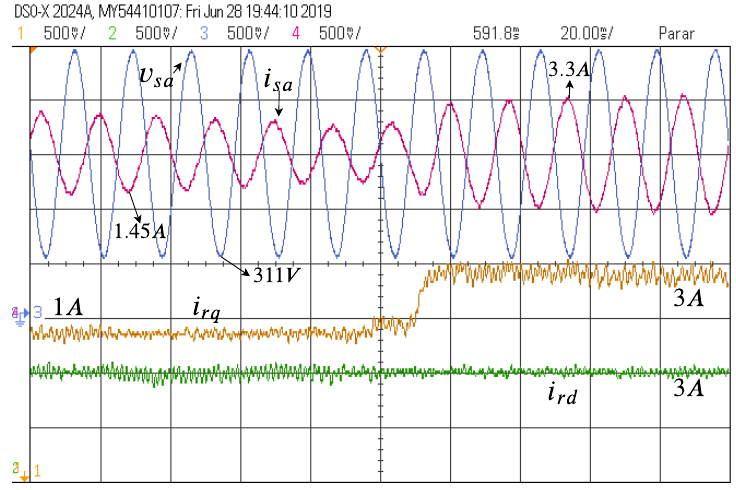
Figure 7. Voltage and current of stator in phase A , considering an i rq step.